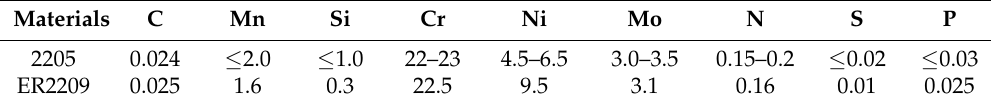
Table 1. Chemical compositions of 2205 and ER2209.